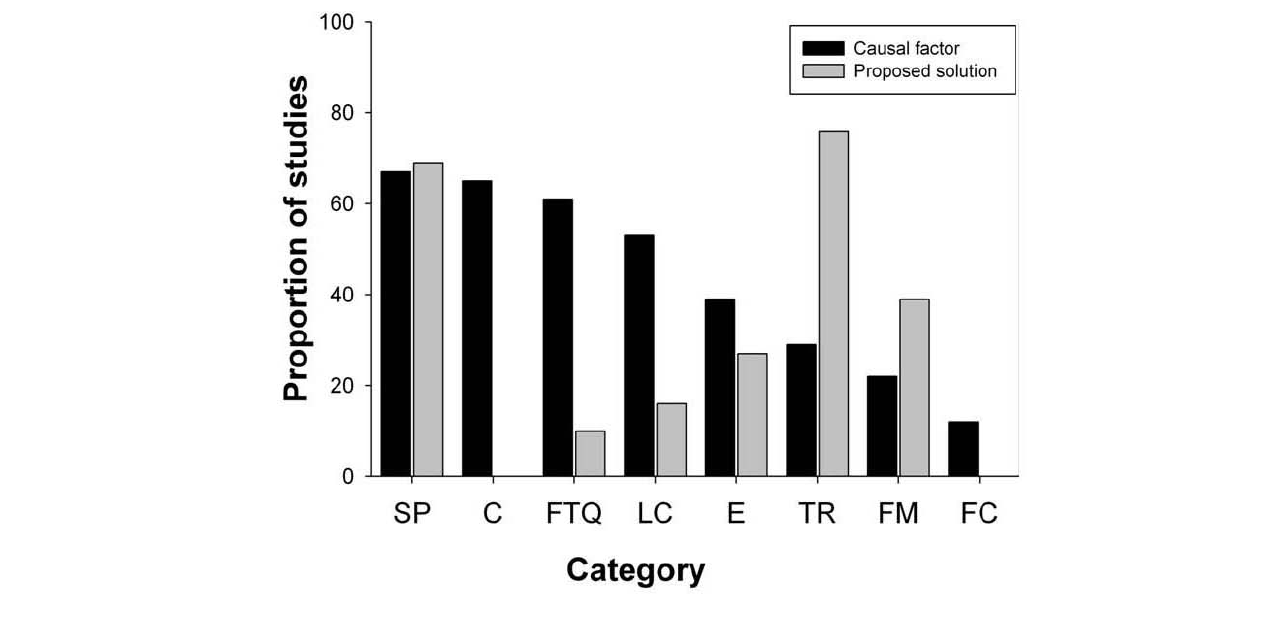
Fig. 1. Proportion of total number of studies identifying the causal factor and solution categories (SP – socio-political; C – climatic; FTQ – forest type and quality; E – economic; LC – landscape context; TR – technological and research; FM – direct fire management; FC – fire characteristics), all methods